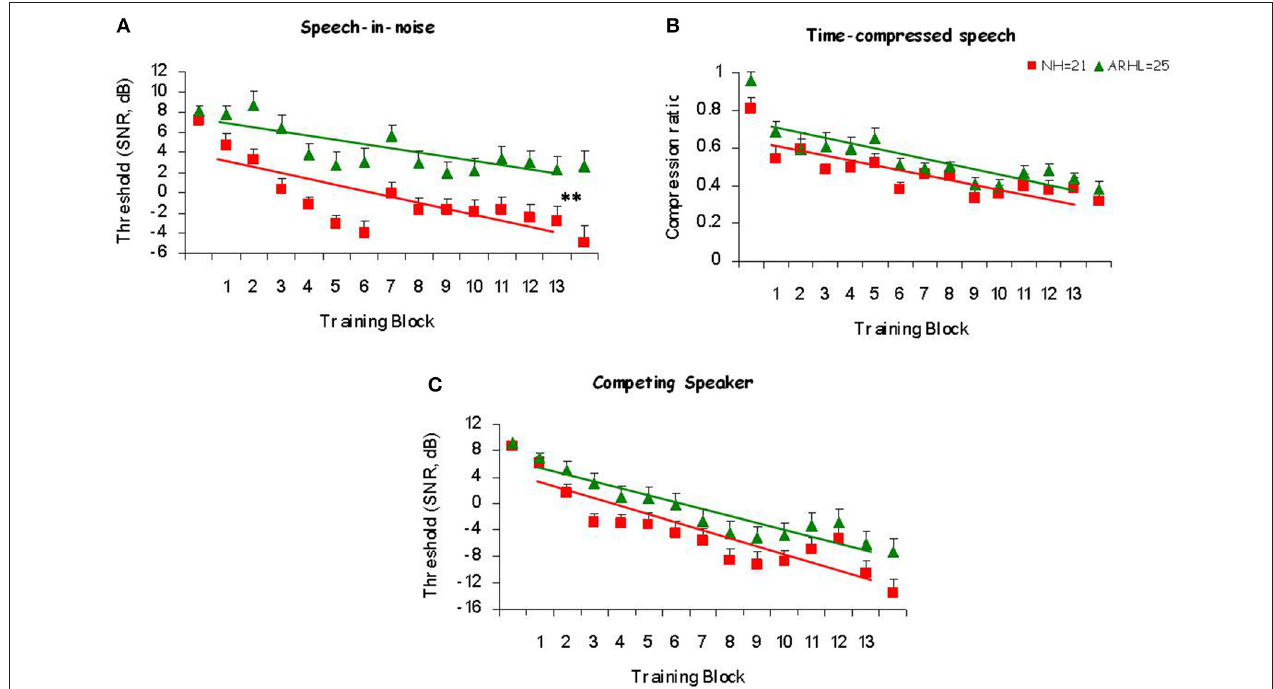
FIGURE 3 | Learning curves. Mean thresholds as a function of the trained block for trained Normal-Hearing (NH) and trained Age-Related Hearing Loss (ARHL) participants in (A) Speech-in-noise (B) Time-compressed speech and (C) Competing speaker conditions. Mean signal-to-noise ratio (SNR) thresholds of each block was used as the dependent measure in speech-in-noise and competing speaker conditions and the compression ratio was used for the time-compressed speech condition. Regression lines and slopes of the learning curves (A) for trained NH are shown in red and for trained ARHL in green. ** p < 0.01 .